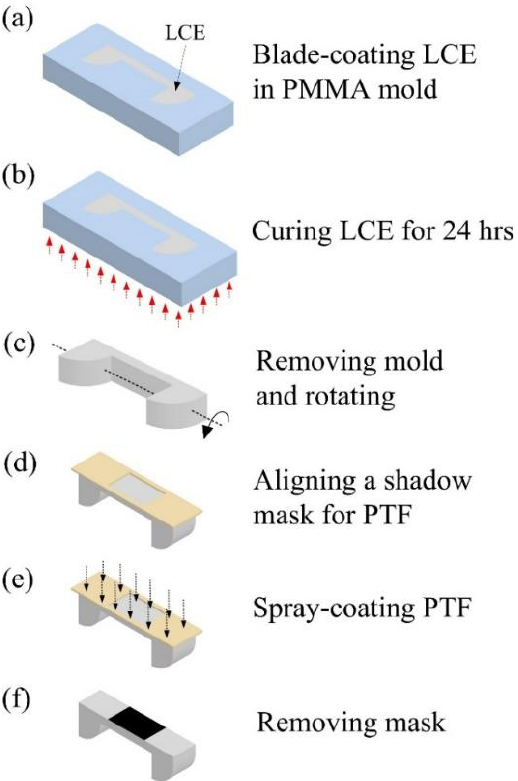
Figure 2. The fabrication process of forming the structure of the light-driven LCE device. Figure 3 illustrates that the shape programming of the LCE was realized by using a method combining mechanical stretching and thermal cross-linking. The mechanical stretching process is equivalent to an embossing technique that aligns the LC molecules with a specially designed PMMA mold. The mold, which has specially designed features of shapes, was pressed against the LCE structure (Figure 3a) and then cured for 24 h under a 365 nm UV light (Figure 3b) to program permanently aligned monodomain LCE samples for achieving shape deformation under external stimuli. This process changed the shape of the previous structure (as shown in Figure 2f) into the shape defined by the PMMA mold. The embossing process provides several advantages, such as producing three-dimensional structures, a relatively low cost, simple operation, and high replication accuracy for small features. Finally, the fabricated device was removed from the mold, as shown in Figure